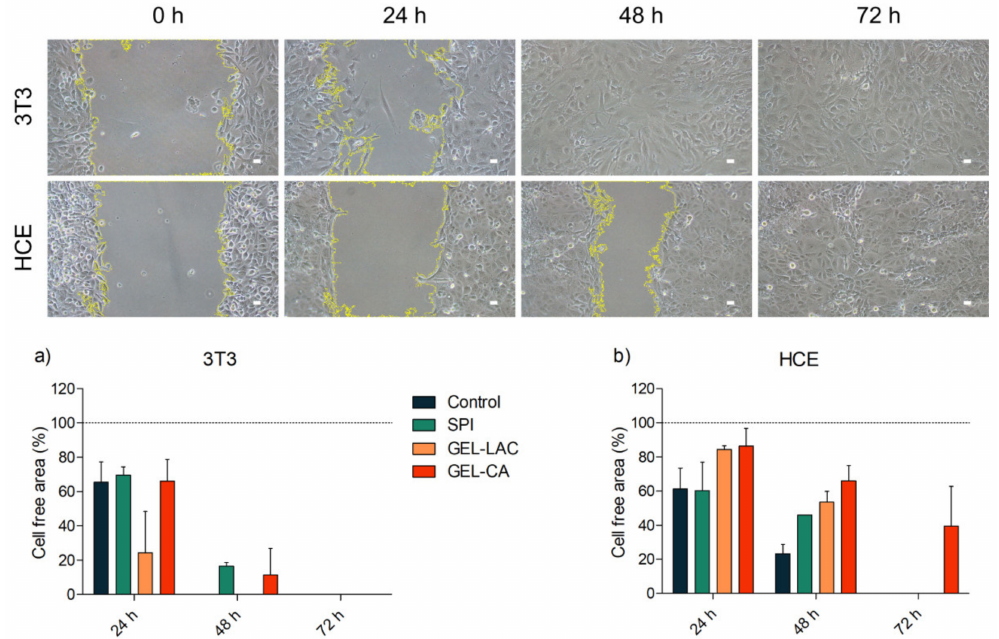
Figure 8. Migration assay of HCE and 3T3 cell seeded above GEL-LAC after 24, 48, and 72 h. Images taken with 10 × magnification; scale bars correspond to 25 µ m. Data in ( a ) and ( b ) represent the evolution of the gap closure by 3T3 ( a ) and HCE ( b ) cells in each